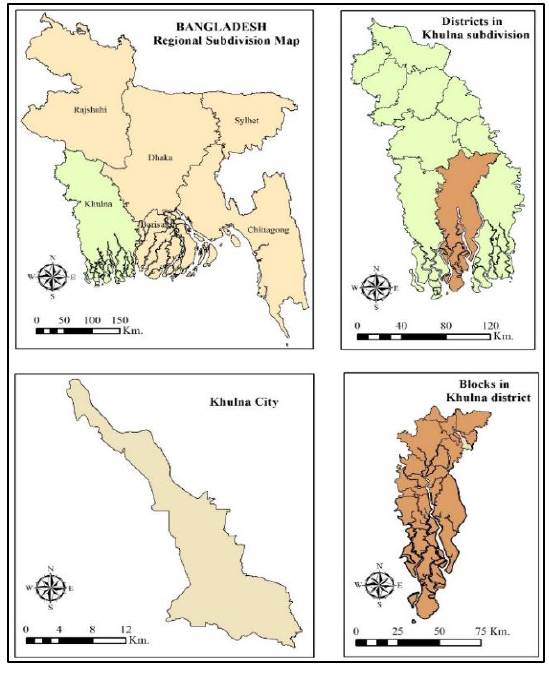
Figure 1. Study Area